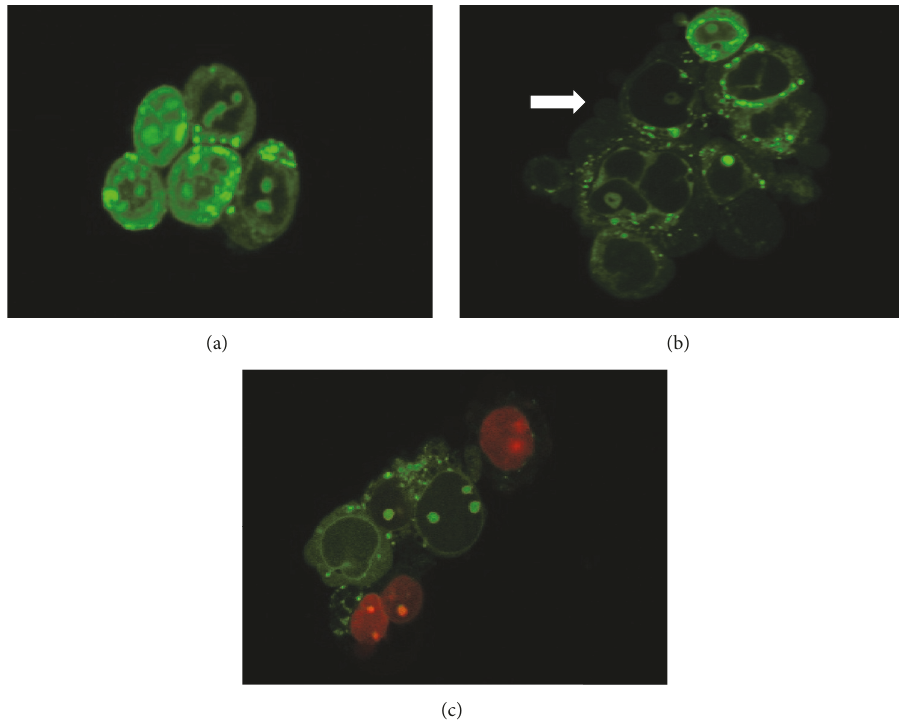
Figure 5: Fluorescent photomicrographic evidence of HT-29 cells 24 h after treatment. Morphological changes following exposure to treatment are typical of apoptosis; A: viable cell, B: apoptotic cell, C: necrotic cell. The arrow ( ) shows membrane blebbing—one of the characteristics of apoptosis. This was viewed using a laser confocal inverted microscope at magnification of